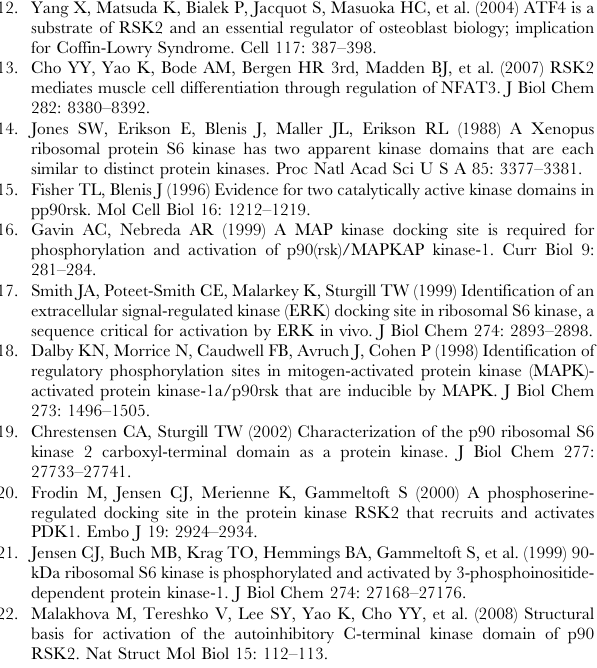
Figure S3 Western blot confirms an equal level of ectopically expressed proteins - wild type full length RSK2 and